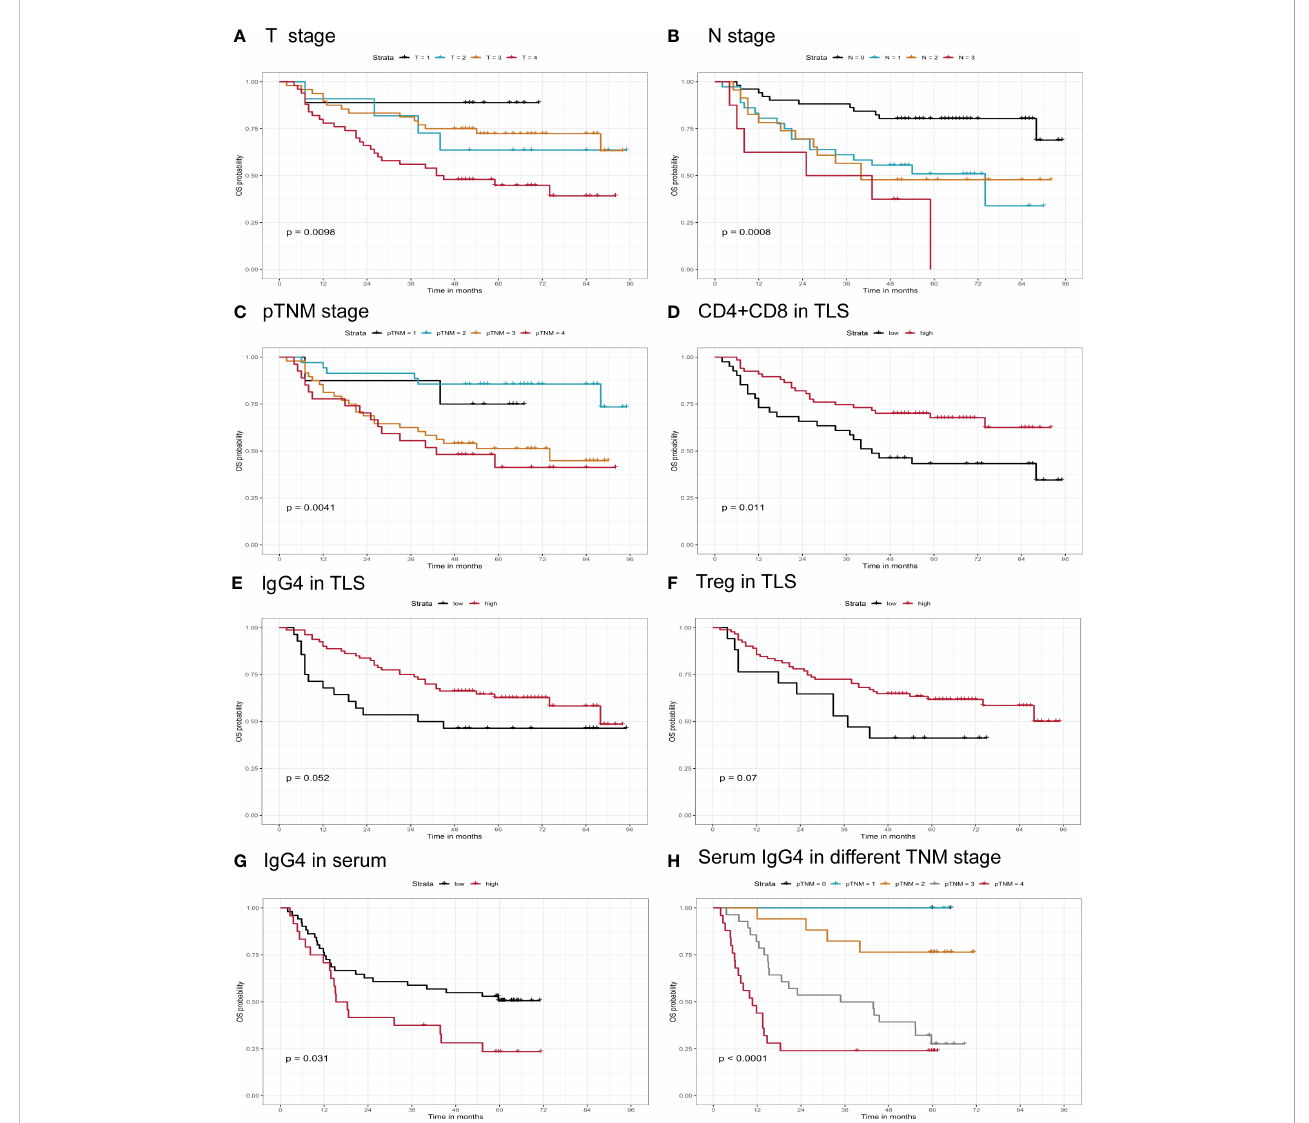
FIGURE 3 Correlation of in fi ltrating immune markers and patients ’ clinical survival time. (A – F) Overall survival of patients grouped by different T stage, N stage, pTNM stage, CD4+CD8, IgG4, Treg in TLS in fi ltrating status (n=118). (G, H) Serum IgG4, serum IgG4 in different TNM stage in Kaplan-Meier survival analysis